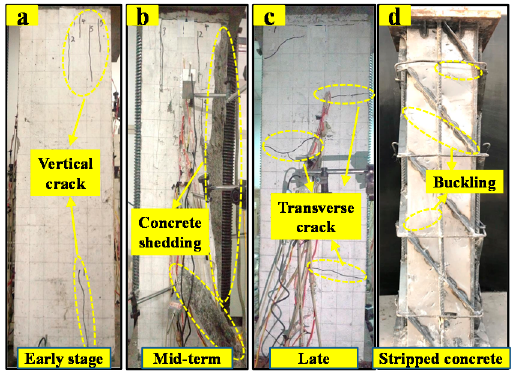
Figure 7. Z3 destruction phenomenon. ( a ) Early stage ( b ) medium stage ( c ) Late stage ( d ) Stripped concrete.